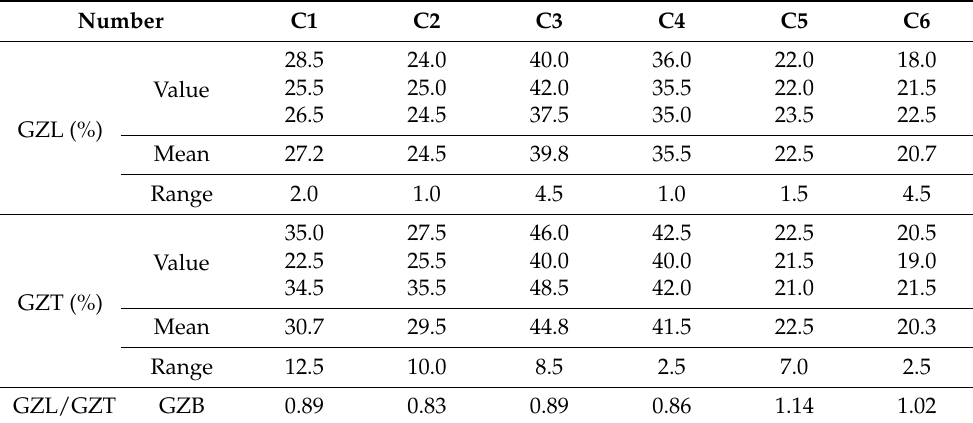
Table 7. The measured value of gloss for Group C.